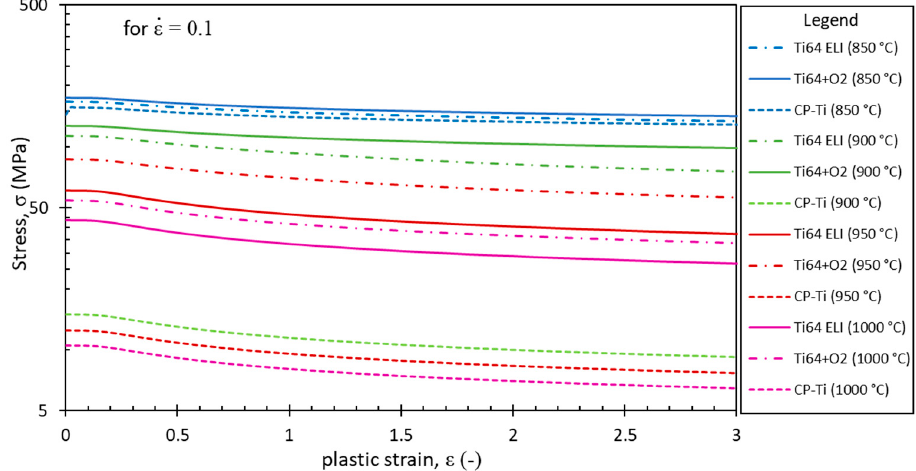
Figure 4. Stress–strain data for a range of operating temperatures, at a fixed strain rate, for Ti-6Al-4V (ELI), Ti-6Al-4V plus higher O 2 pick-up, and for CP-Ti.